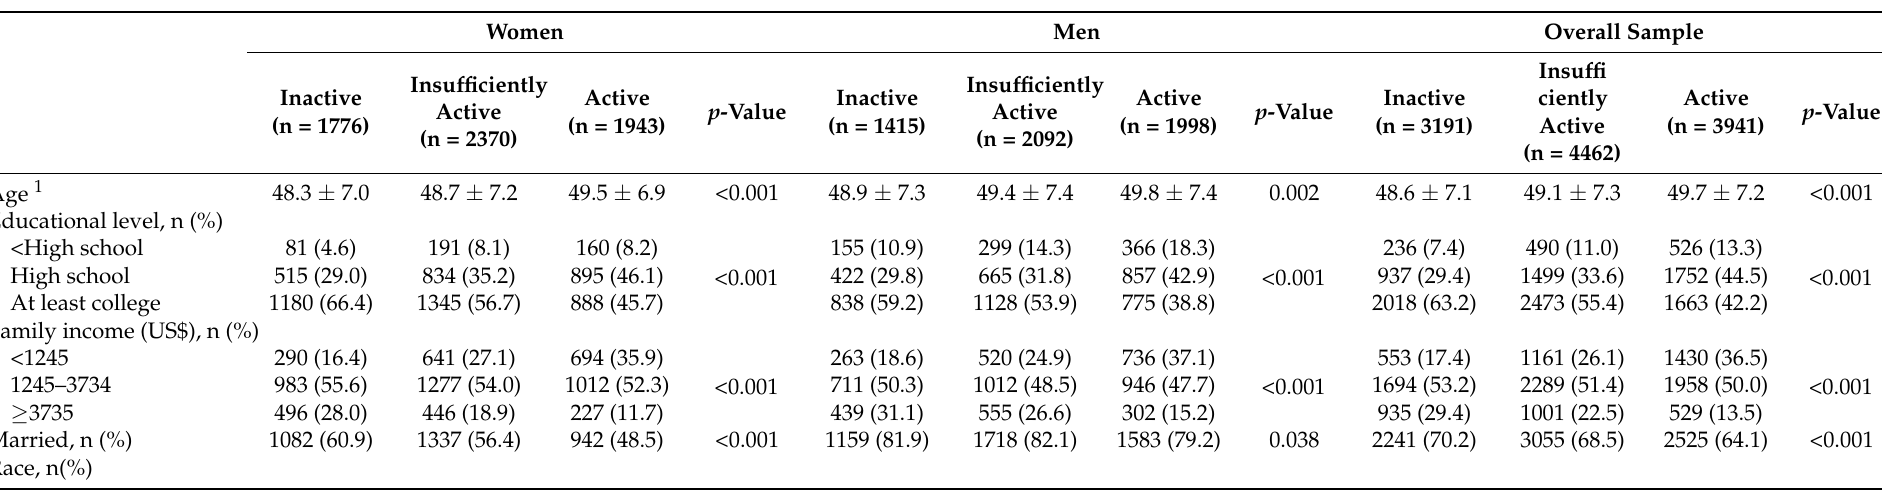
Table 2. Descriptive characteristics, according to level of physical activity at commuting in baseline participants of ELSA-Brasil study (n =